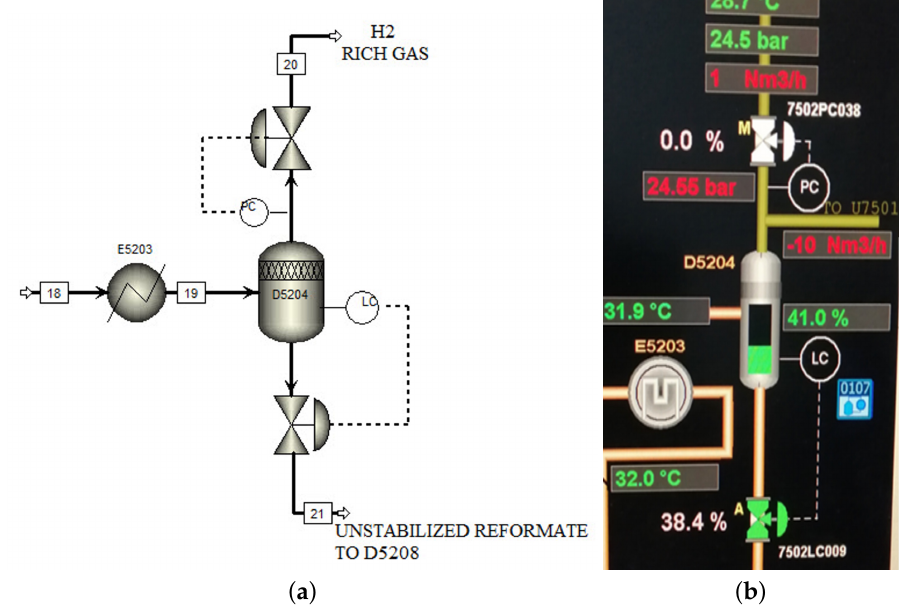
Figure 2. DRUM D5204 schematic diagram: ( a ) schematic diagram; ( b ) graphical user interface